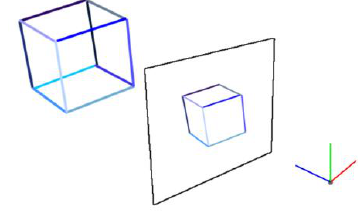
Figure 7. Edge-ID method.